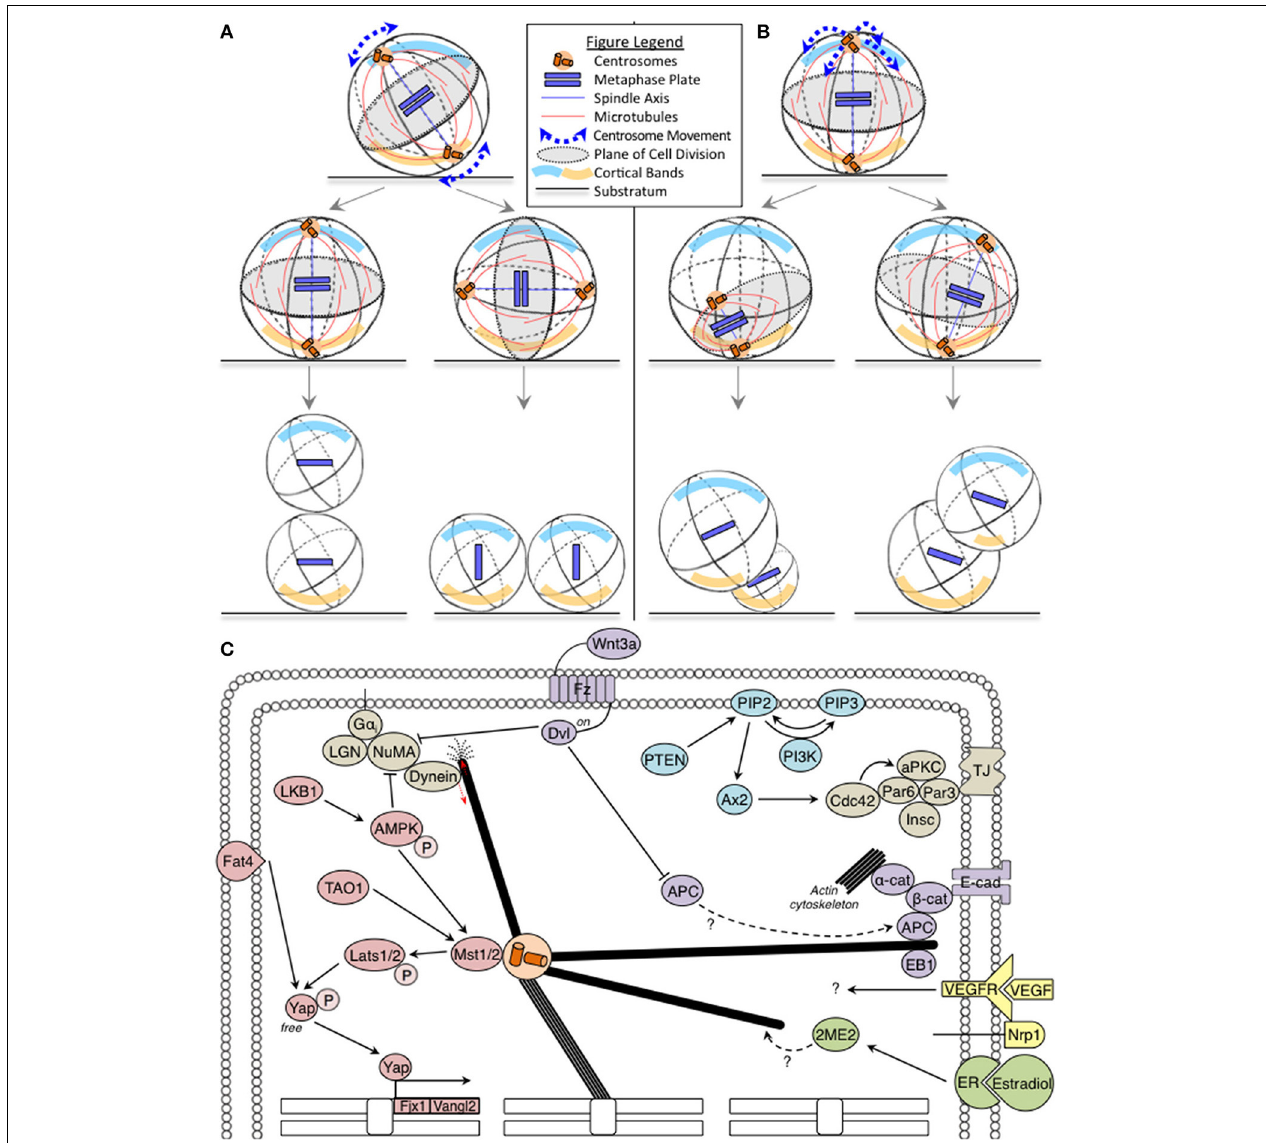
FIGURE 1 | (A,B) Fates of incorrect spindle orientation and positioning: Cartoons show mitotic spindle movements relative to the substratum leading to spindle mis-orientation (A) and mis-positioning (B) with cortical bands highlighting polarity differences. In (A) , misorientation alters the relative positions and contents of daughter cells, without affecting progenitor cell sizes. In (B) , mispositioning affects daughter cell size, relative positions and their contents. Legend describing cell substratum, spindle microtubules, metaphase plate, and spindle